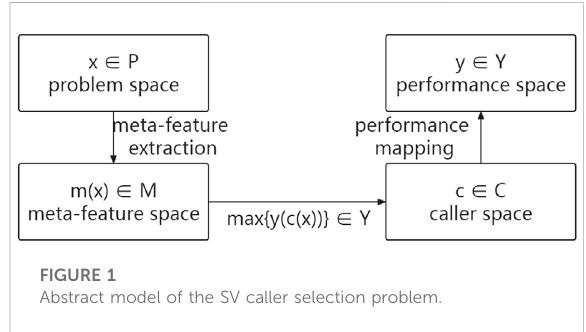
FIGURE 1 Abstract model of the SV caller selection problem.